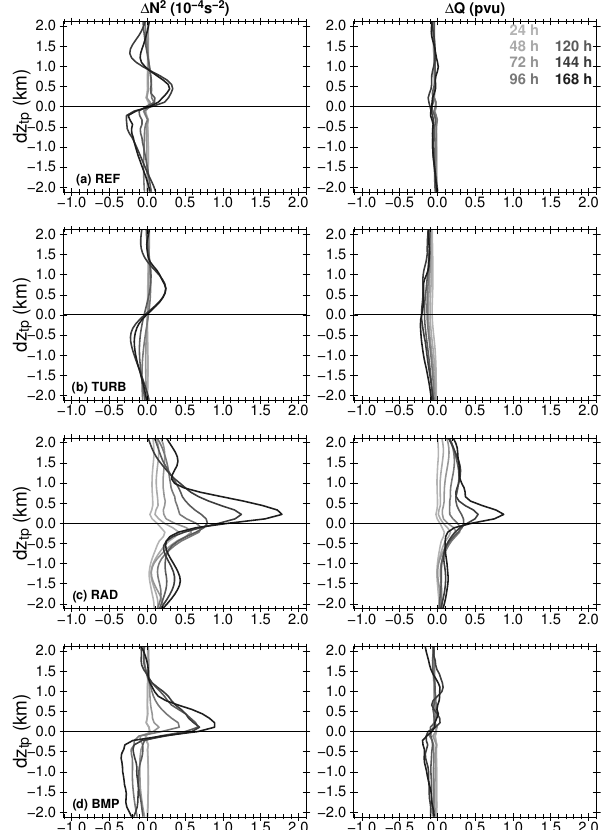
Figure 6. Instantaneous thermal tropopause-based domain mean values of (cid:49)N 2 (in 10 − 4 s − 2 ) in the left panels and (cid:49)Q (in pvu) in the right panels for (a) REF, (b) TURB, (c) RAD, and (d) BMP. The domain mean is calculated within 25–65 ◦ latitude and the en- tire zonal domain. The intensity of the gray colors indicates the time since model start in 24h intervals. (cid:49)N 2 is the difference between the current static stability N 2 and the advected initial static stability N 2 , (cid:49)Q is the difference between the current potential vorticity Q 0 and the advected initial potential vorticity Q 0 . d z tp is the distance to the height of the thermal